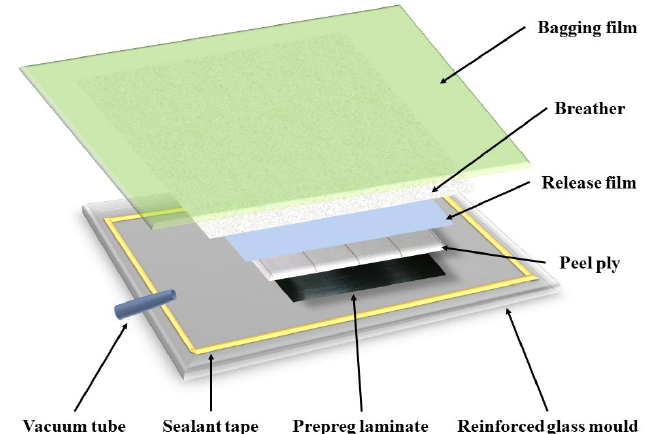
Figure 2. Schematic diagram of the recently developed microwave oven and composite plate used in the experiment.